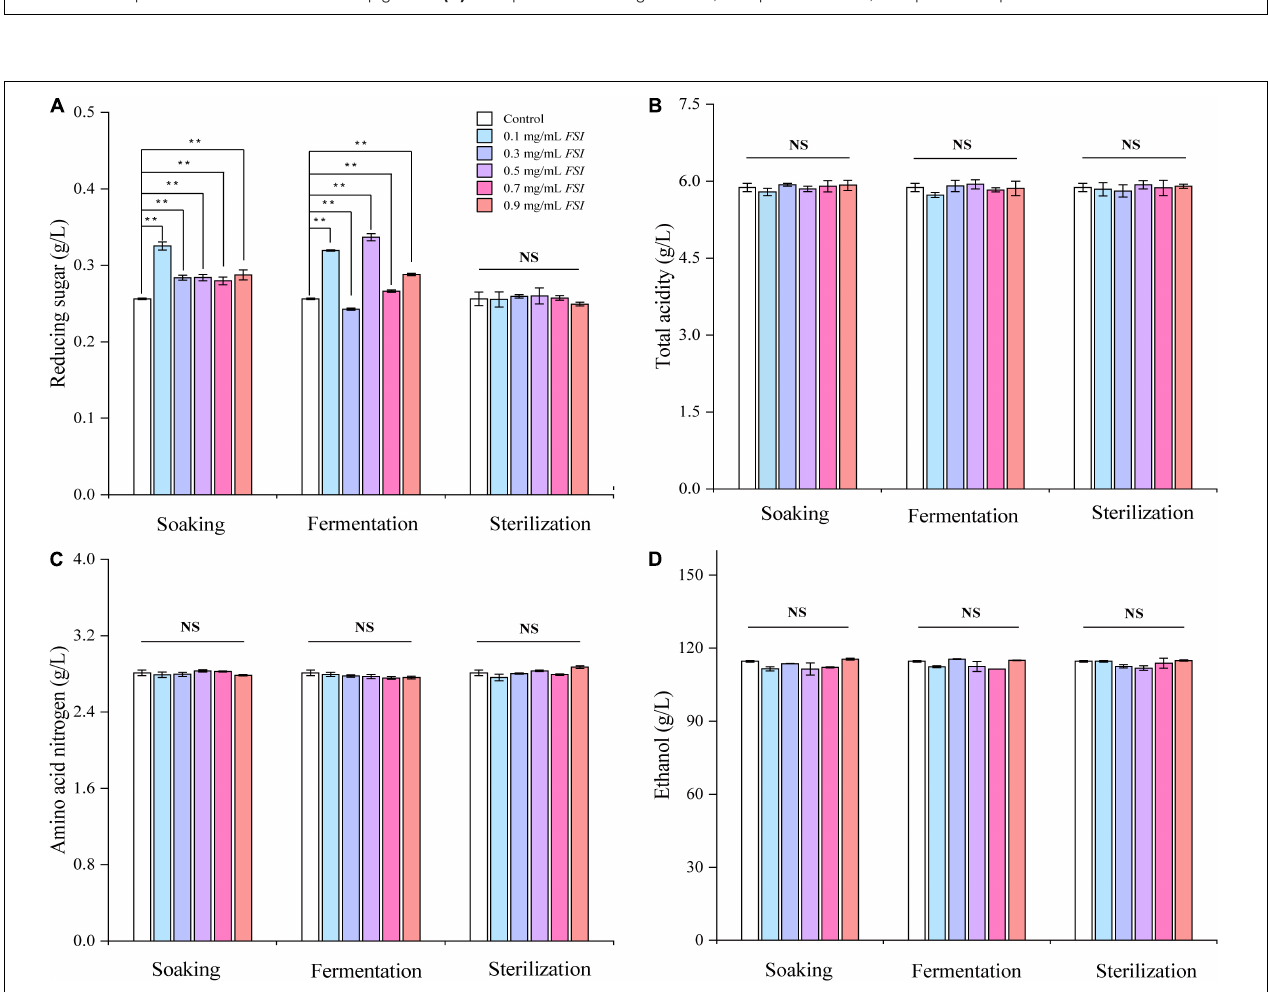
FIGURE 2 | Effective constituent of FSI in the preservation of Monascus pigments. HPLC results of reference substances (A) and FSI (B) . Effect of quercetin, rutin, and FSI on the preservation rate of Monascus pigments (C) . Component 1: chlorogenic acid; Component 2: rutin; Component 3: quercetin.